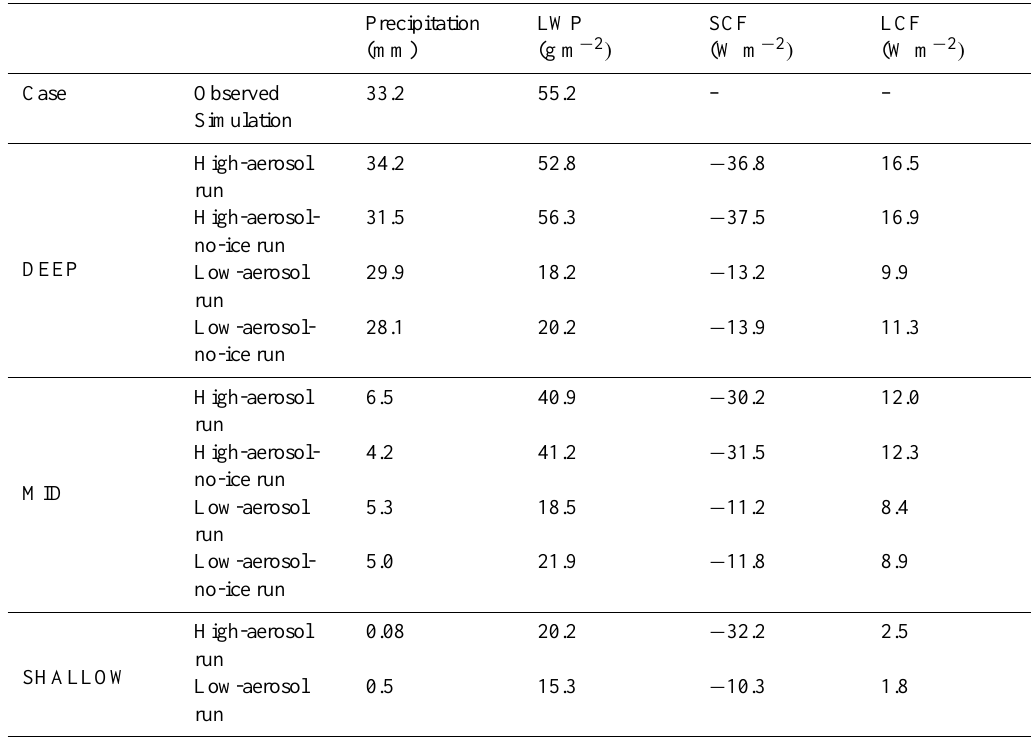
Table 3. Time- and area-averaged precipitation, liquid-water path (LWP) and top-of-the-atmosphere (TOA) shortwave cloud forcing (SCF) and longwave cloud forcing (LCF).